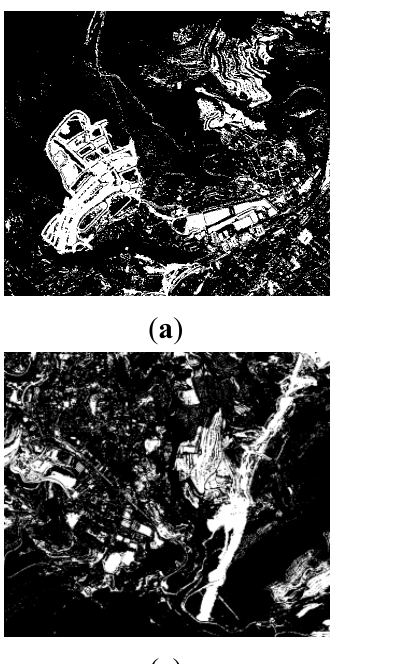
Figure 7. Level 2 thresholded indices: best results ( a ) Area A1: Diff. Index–Li method (binary image); ( b ) Area A1: NDVI–Otsu method (binary image); ( c ) Area A2: Diff. Index–Li method (binary image); ( d ) Area A2: Ratio Index–Otsu method (binary image).